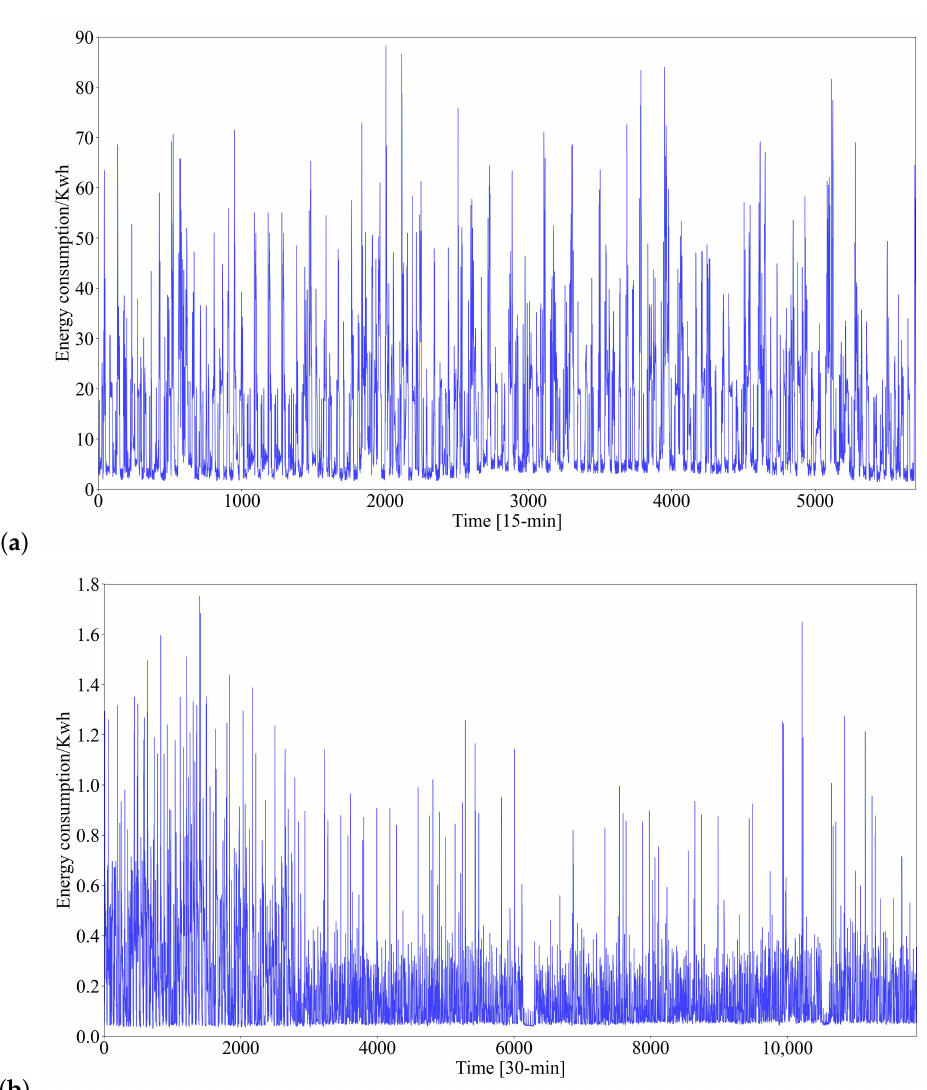
Figure 8. Visualization of selected datasets: ( a ) IHEPC at a 15-min resolution; ( b ) SGSC at a 30-min